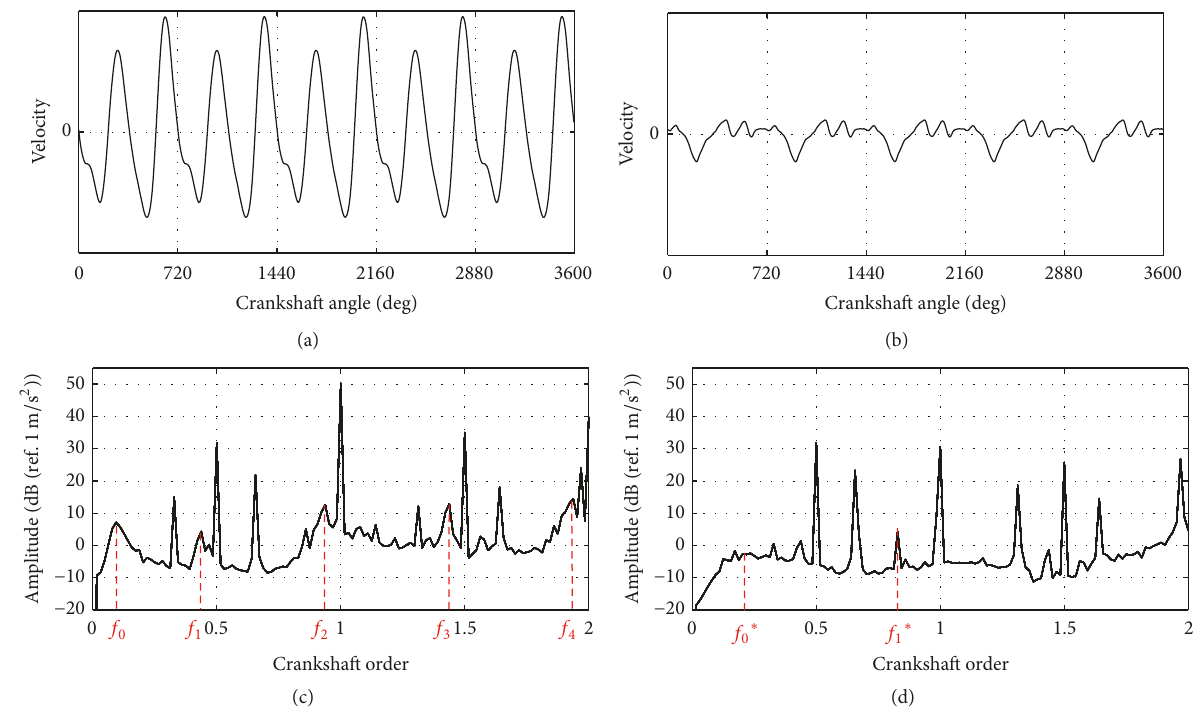
Figure 9: Crankshaft-angle-based trend (reported over five thermodynamic cycles) and order-based spectral analysis of 𝑛 rel for Regime C: (a, c) 45 Sh and (b, d)